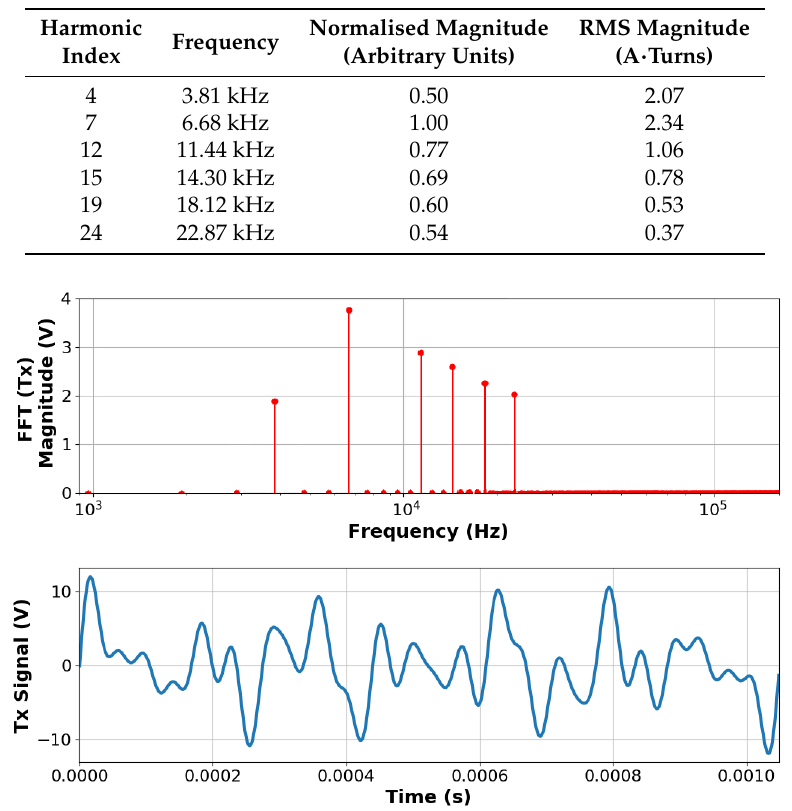
Table 1. MIS transmit signal characteristics.